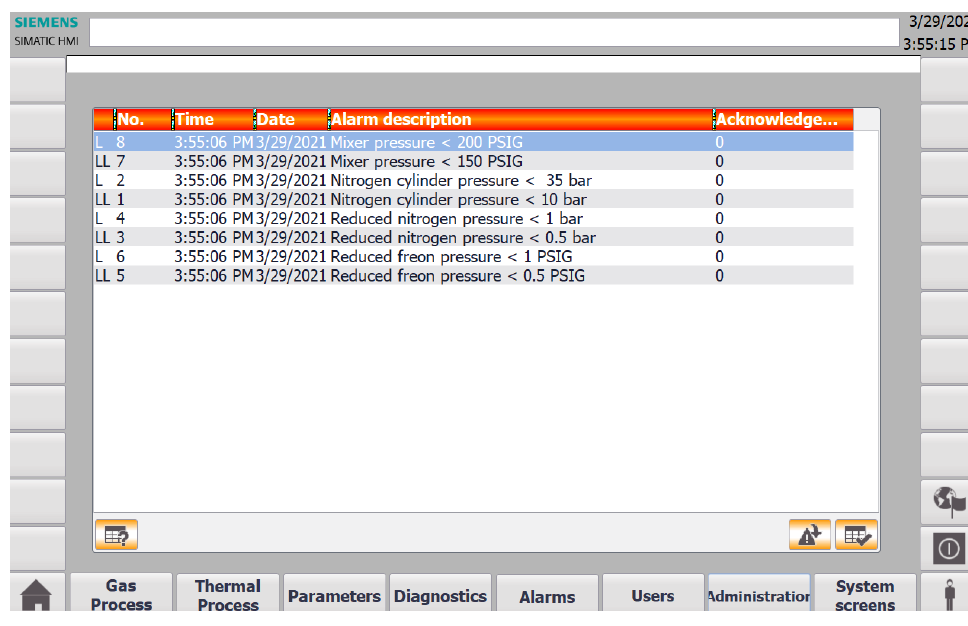
Figure 12. The digital twin SCADA gas process alarms screen.